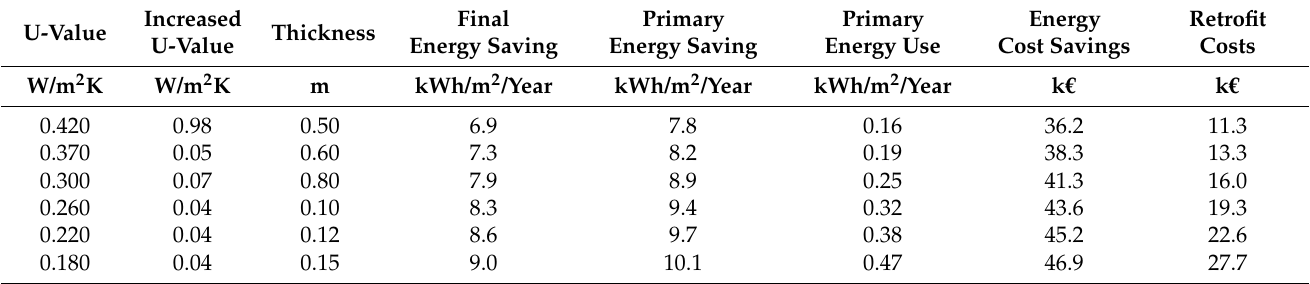
Table 4. Thicknesses, final and primary energy savings, energy cost savings, and retrofit costs of extra insulation of polystyrene (XPS) on basement walls with improved